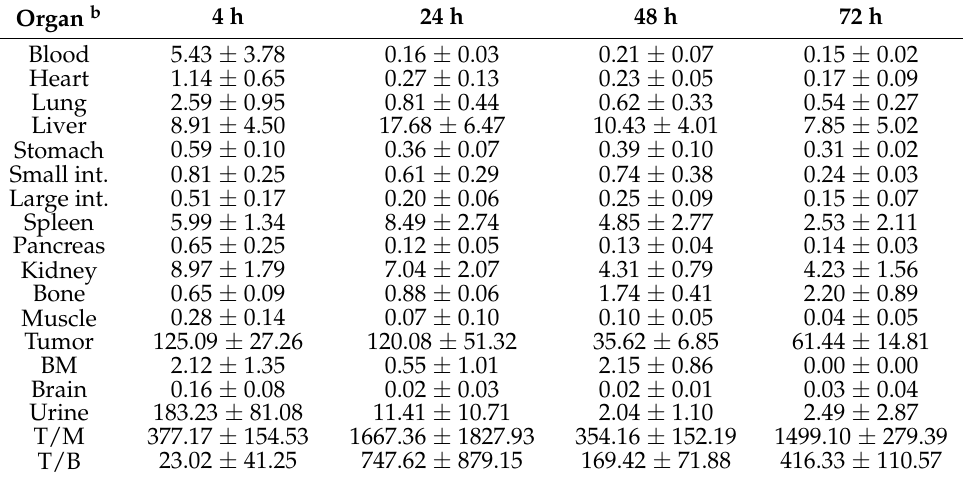
Figure 2. Biodistribution analysis of 177 Lu-DTPA (Blue bars) and 177 Lu-DTPA-pAuNS (Red bars) after intratumoral injection in orthotopic HNSCC tumor-bearing mice. Radioactivity distribution in each organ is demonstrated by bar chart (n = 4). Table 1. The biodistribution of 177 Lu-DTPA-pAuNS injected intratumorally into tumor-bearing mice a